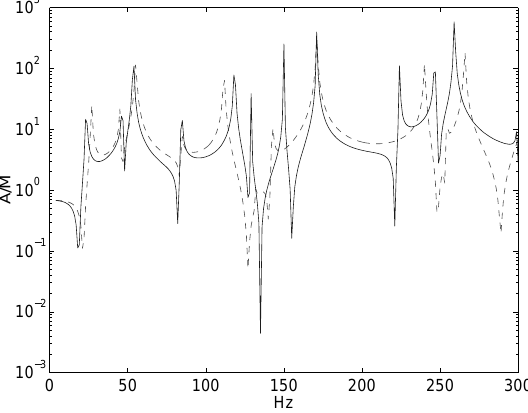
Fig. 3. Frame-plate coupling. Translation/moment FRFs: complete FE model (–); coupling procedure (- - -) using experimental